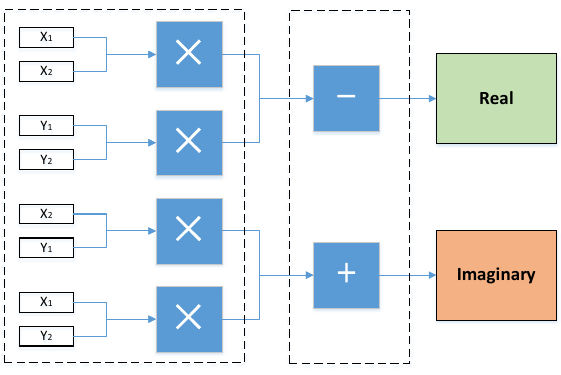
Figure 4. Complex adder and multiplier.